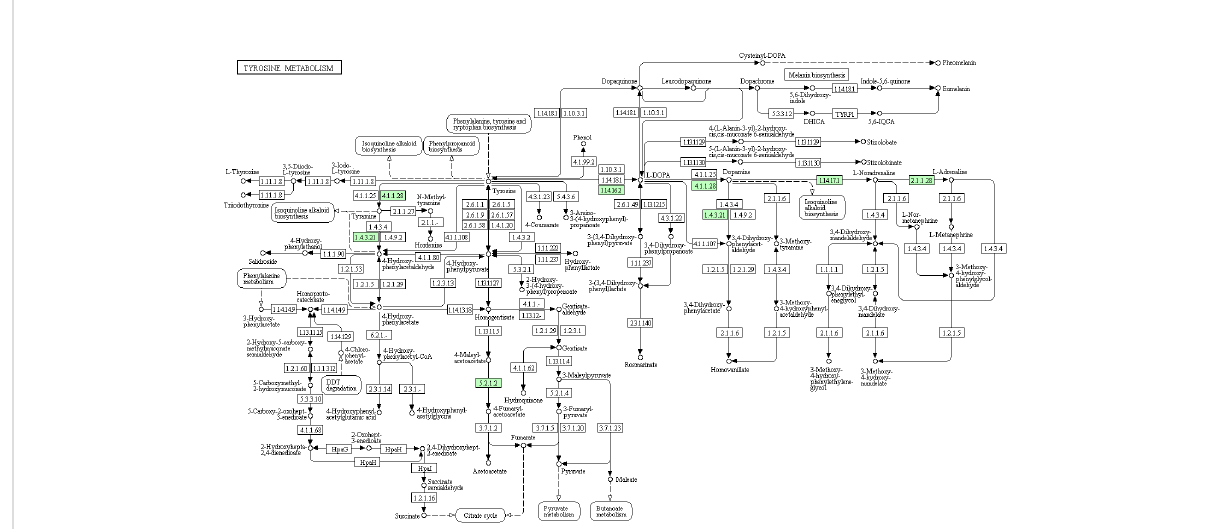
FIGURE 4 KEGG pathway functional analysis results. Major pathways include tyrosine 3-monooxygenase (EC:1.14.16.2), dopamine beta-monooxygenase (EC:1.14.17.1), phenylethanolamine N-methyltransferase (EC:2.1.1.28), tyrosine 3-monooxygenase (EC:1.14.16.2), aromatic-L-amino-acid/L- tryptophan decarboxylase (EC:4.1.1.28/4.1.1.105), maleylacetoacetate isomerase (EC:5.2.1.2), maleylacetoacetate isomerase (EC:5.2.1.2), and primary-amine oxidase (EC:1.4.3.21).